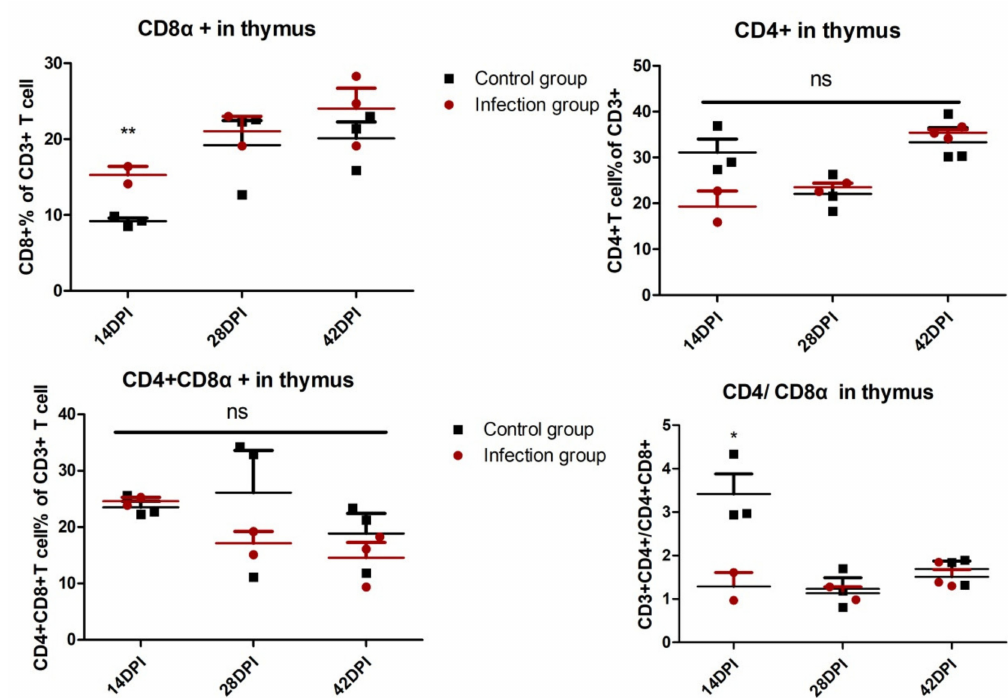
Figure 3. Analysis of T lymphocyte percentage in the thymus. Thymus single-cell suspensions derived from chickens of infected and control groups were isolated to detect the T lymphocyte percentage. Every dot stands for one chicken. The unpaired t-test was used for statistical comparison. ns p > 0.05, *